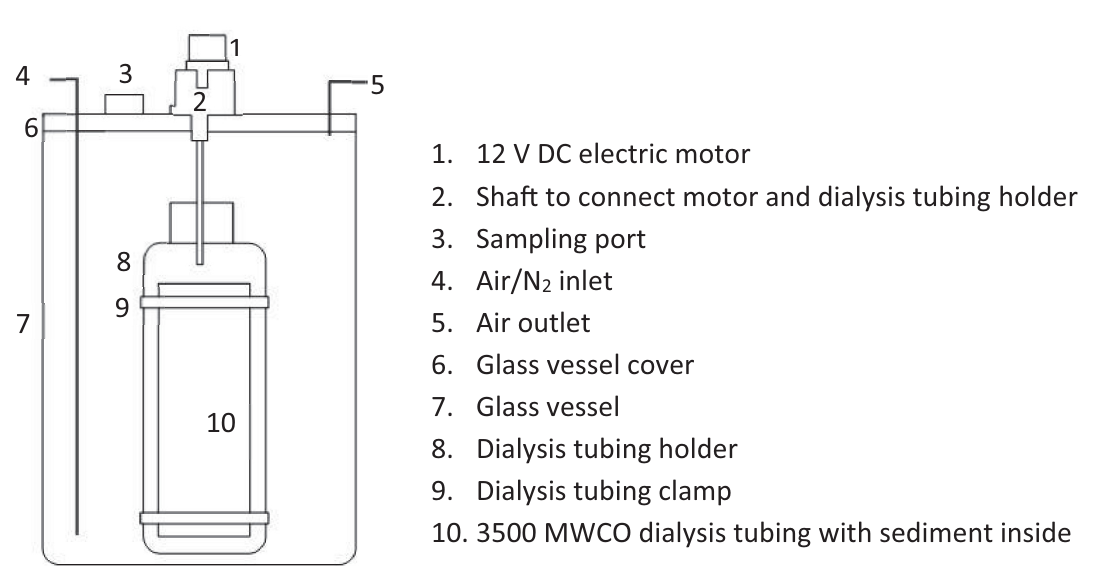
Fig 3. Schematic design of reactor for quantifying P release from the sediments under oxic and anoxic environments.